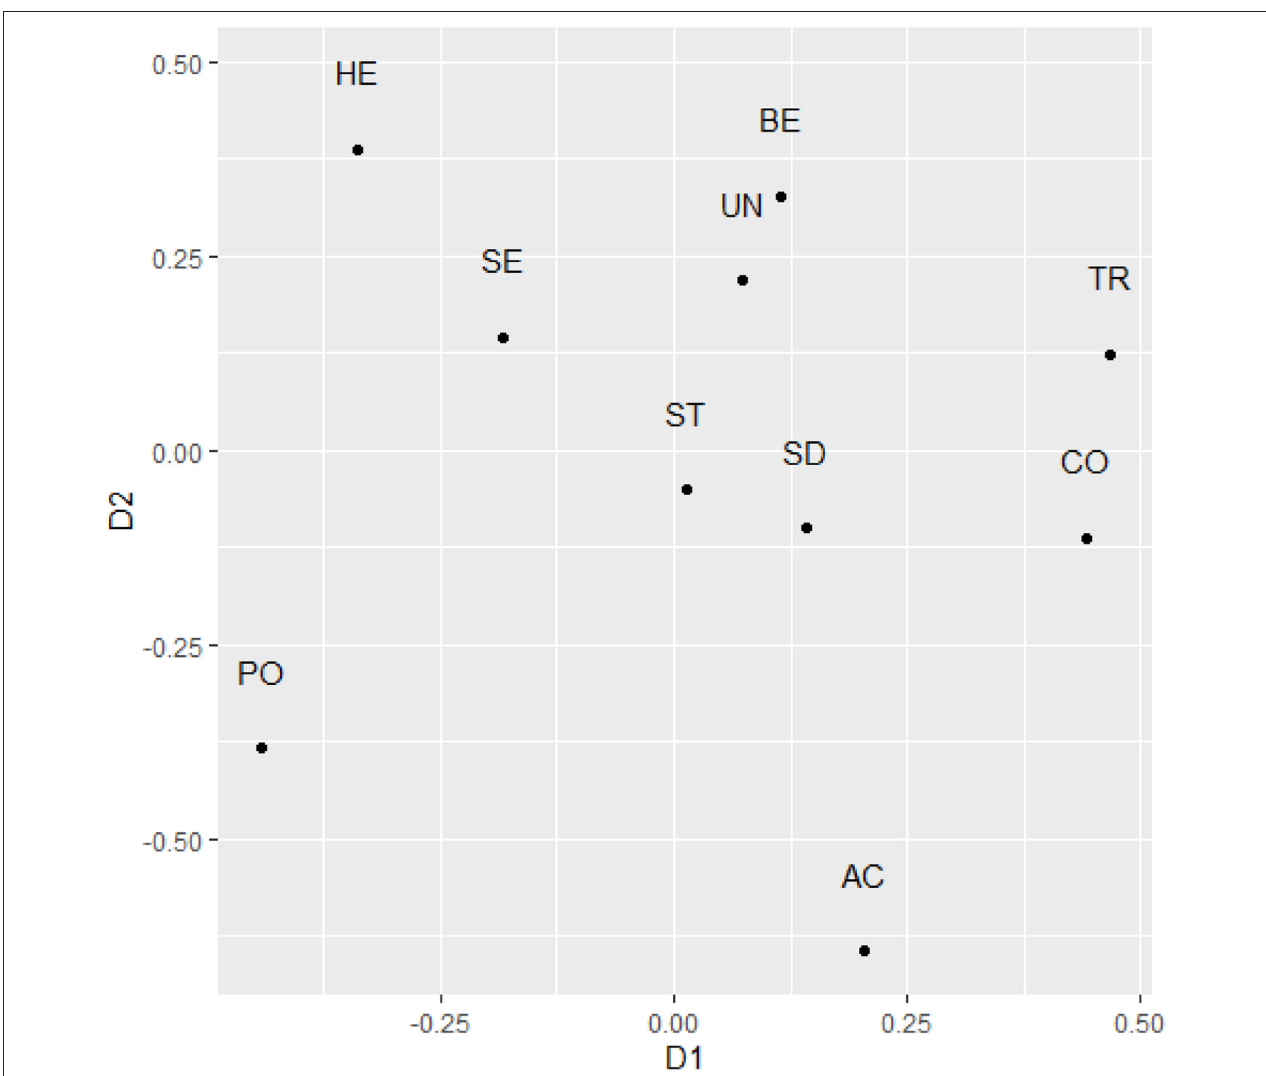
FIGURE 2 | The two-dimensional representation of raw text-based value scores after rotation to maximal similarity with theoretical predictions in Study 1. SD, Self direction; ST, Stimulation; HE, Hedonism; AC, Achievement; PO, Power; SE, Security; TR, Tradition; CO, Conformity; BE, Benevolence; UN, Universalism.